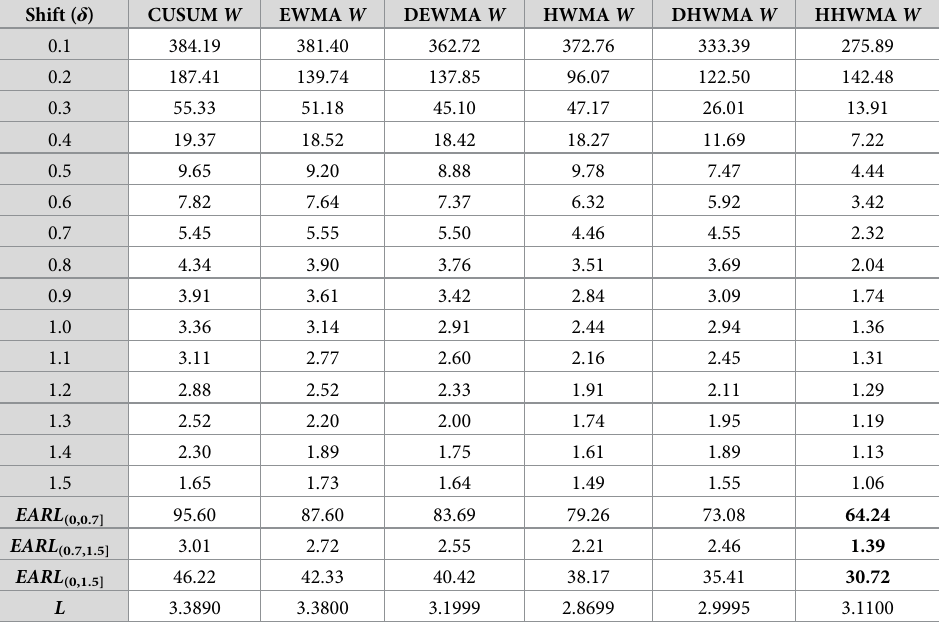
Table 6. The OOC ARL profiles of the proposed HWMA, DHWMA and HHWMA W schemes against the CUSUM, EWMA and DEWMA W schemes when ( m , n , λ )= (100,5,0.5) for a nominal ARL 0 = 500 under t (5)